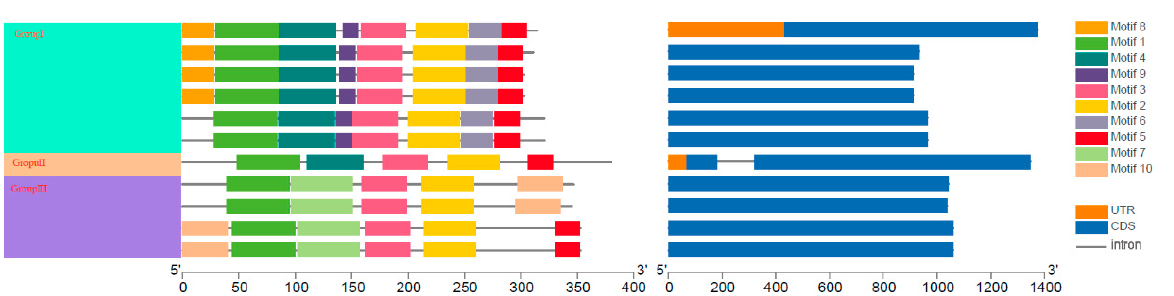
Figure 2. Schematic representation of protein and gene structures of P. bretschneideri RAV genes. Motifs 1–10 identified using the MEME search tool are marked on the protein sequences in each clade (I–III). The length and order of each motif corresponds to the actual length and position in the protein sequences. The coding sequence and untranslated regions are represented by filled dark blue and orange boxes, respectively.